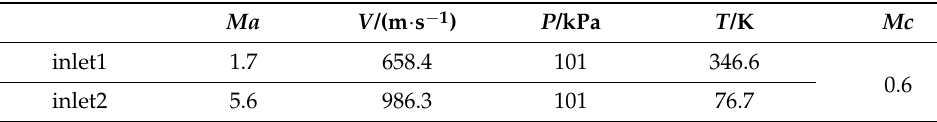
Table 1. Inflow parameters.